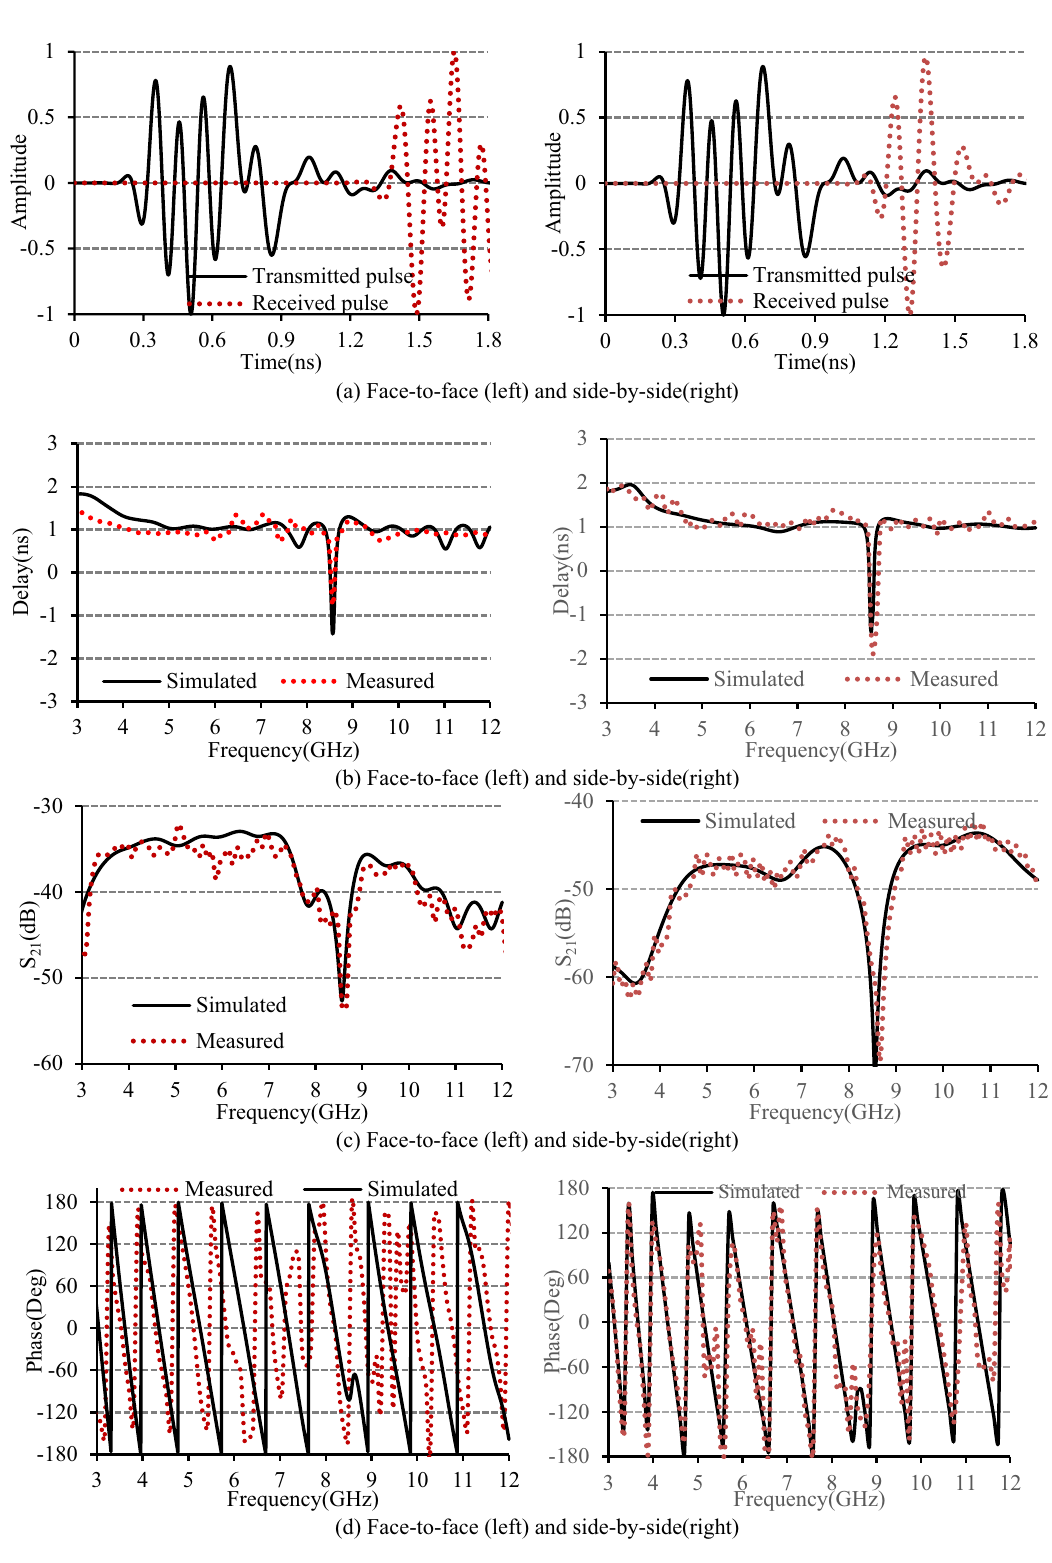
(d) Face-to-face (left) and Figure 10. ( a ) Transmitted and received signal, ( b ) group delay, ( c ) transfer function (S 21 ), and ( d ) phase of S 21